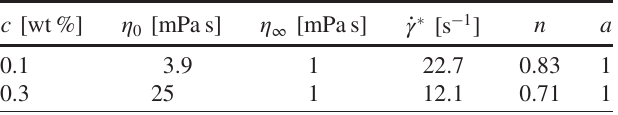
TABLE I. Parameters extracted by fitting the Carreau-Yasuda GNF model [Eq. (1)] to the steady flow curves of the shear- thinning solutions of PEO dissolved in